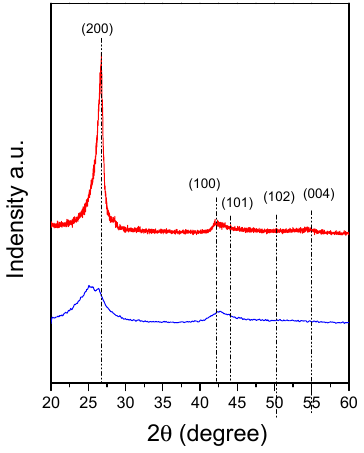
Figure 8. XRD patterns recorded on both TGA residues derived PBN ( blue ) and PBN-Li 3 N ( red ). Table 2. Main XRD parameters of commercial h-BN and TGA residues derived PBN and PBN-Li 3 N. Sample